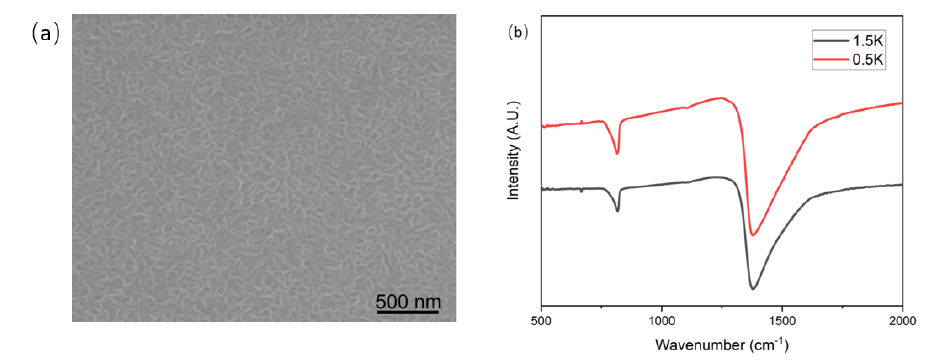
Figure 4. ( a ) SEM image of hBNNS with 1.5 kW ICP power, ( b ) FTIR spectra of BN films deposited on Si wafers with different ICP RF power supply, with other parameters kept the same as those of the sample shown in Figure 2a.